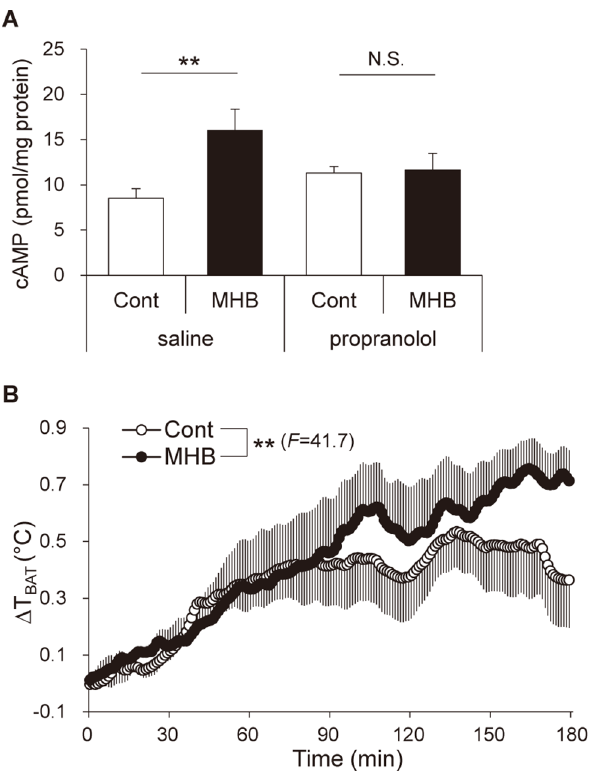
Fig 4. Single oral administration of MHB increased the level of cAMP in BAT and elevated its temperature in rats. (A) cAMP level in the lysates of BAT obtained from rats administered MHB pretreated with propranolol or saline. Thirty minutes after the pretreatment with 10 mg/kg propranolol or saline, rats were administered 10 mg/kg MHB and killed after 3 h. Data are presented as means ± SEM. n = 10 rats/group. ** P < 0.01, N.S., not significant (by unpaired Student ’ s t -test). (B) Time course of BAT temperature changes ( Δ T BAT ) taken every 1 min relative to the baseline. The baseline was determined as the mean T BAT over a 5-min period before the administration of MHB. Urethane-anesthetized rats were administered 10 mg/kg of MHB. Data are presented as means ± SEM. n = 4 rats/group. ** P < 0.01 (by ANOVA with repeated